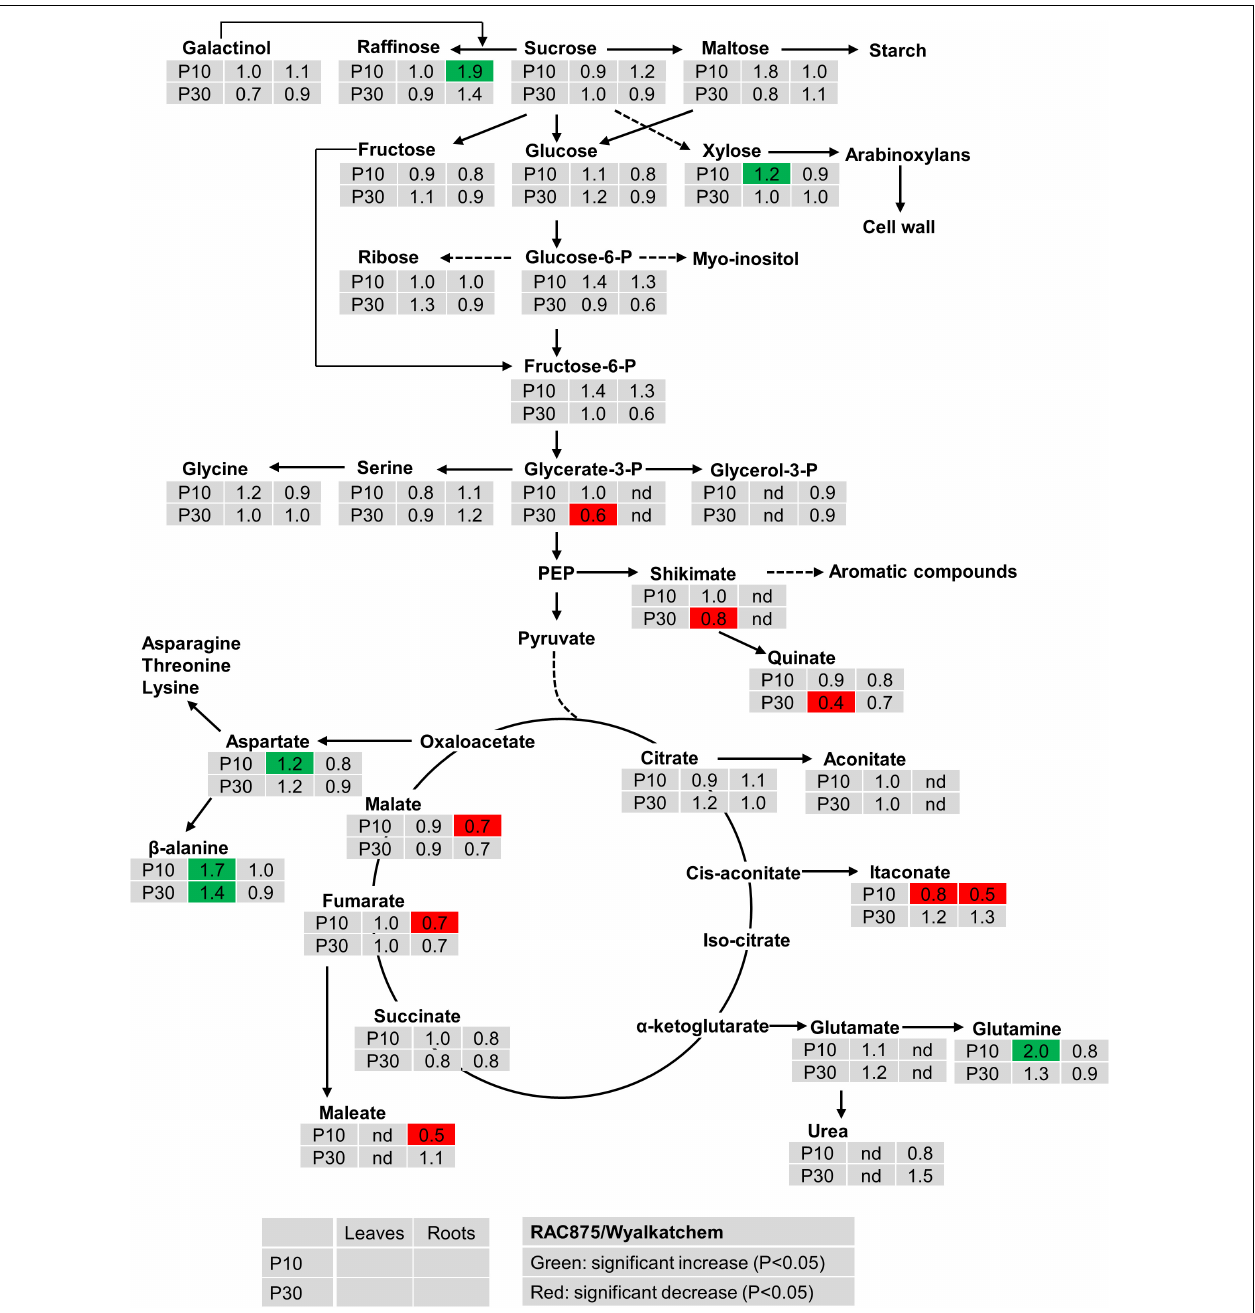
FIGURE 2 | Variation in the levels of metabolites from shoots and roots between two wheat genotypes RAC875 and Wyalkatchem at 28 days after sowing (DAS). Plants were grown in sandy soils at low (10 mg P kg − 1 soil – P10) and adequate (30 mg P kg − 1 soil – P30) P supply. Relative ratios between RAC875 and Wyalkatchem in shoots (the first column) and roots (the second column) are presented as means of four biological replicates and relative ratios were compared at low P (P10) (the first row) and adequate P (P30) (the second row). Significant increases ( P < 0.05) are indicated in green and significant decreases ( P < 0.05) are indicated in red; nd, not